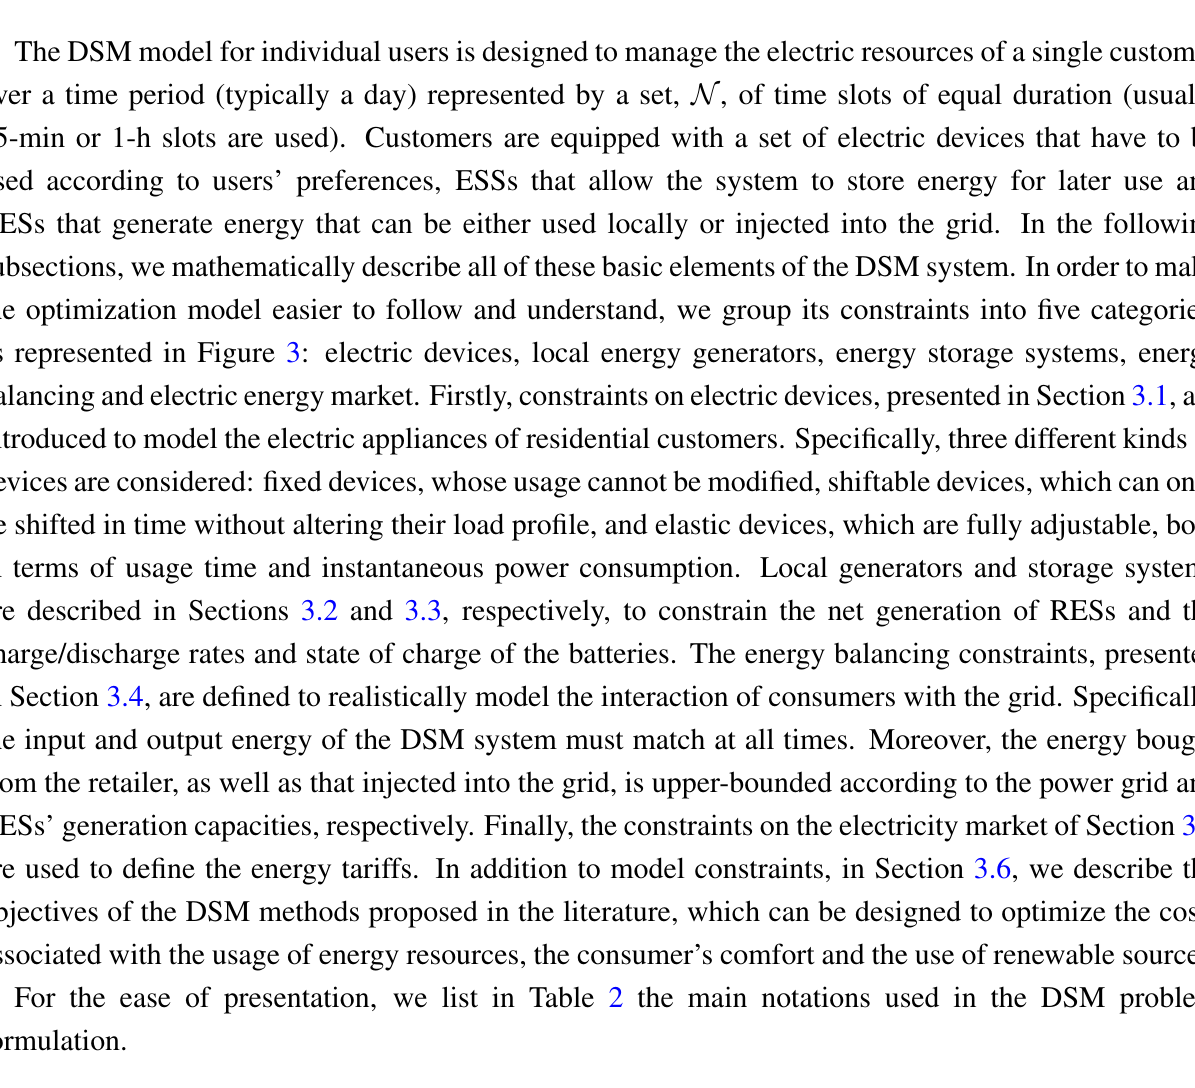
Figure 3. Constraints and objective functions of the DSM optimization